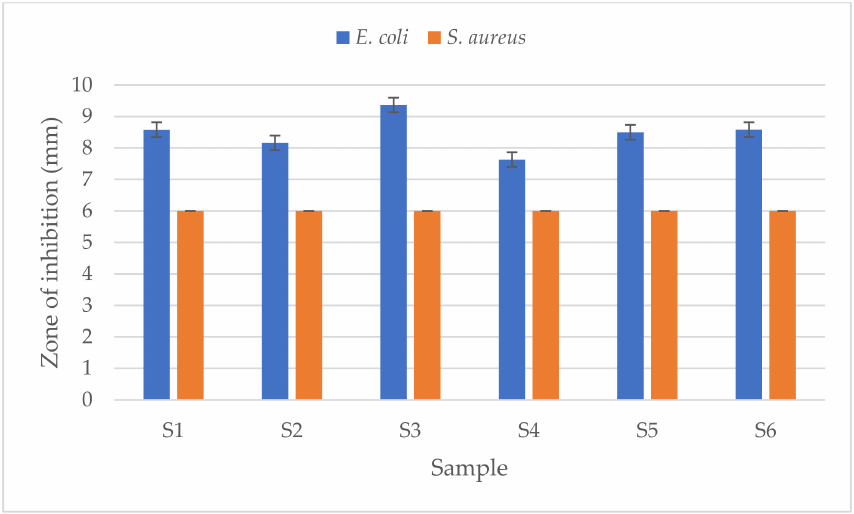
Figure 7. Zone of inhibition: Ti-HA composites (S1–S6) with concentrations of 100 mg/mL against Escherichia coli and Staphylococcus aureus